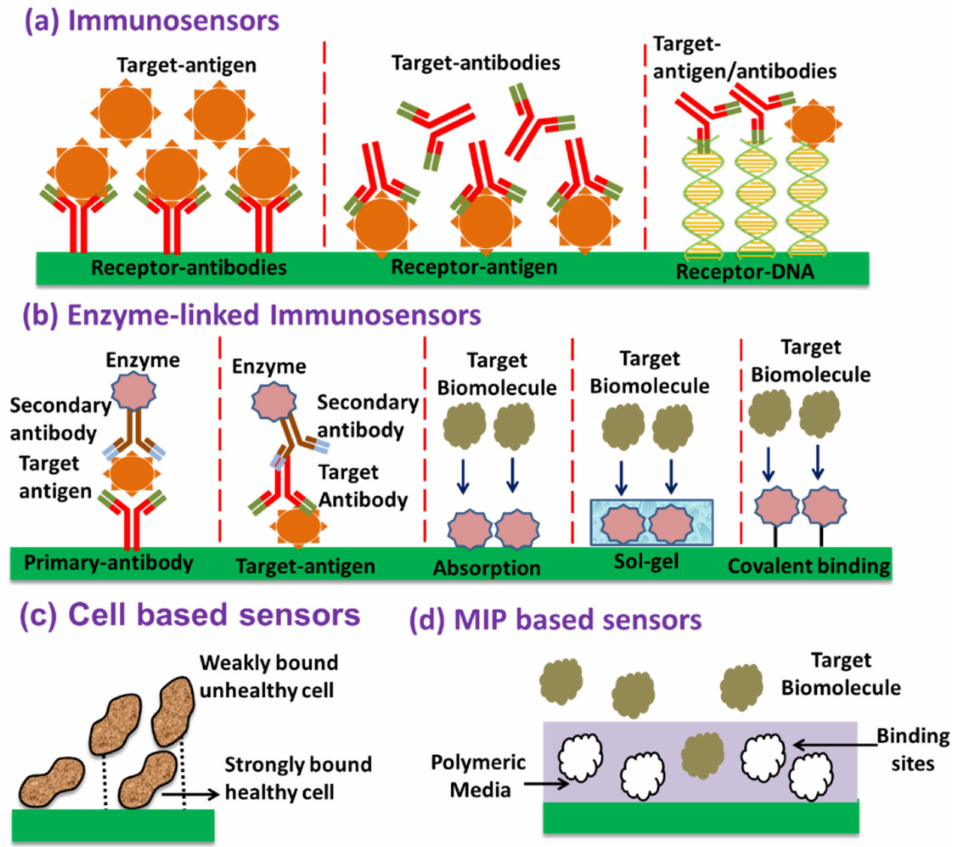
Figure 20. Biosensors based on various recognition